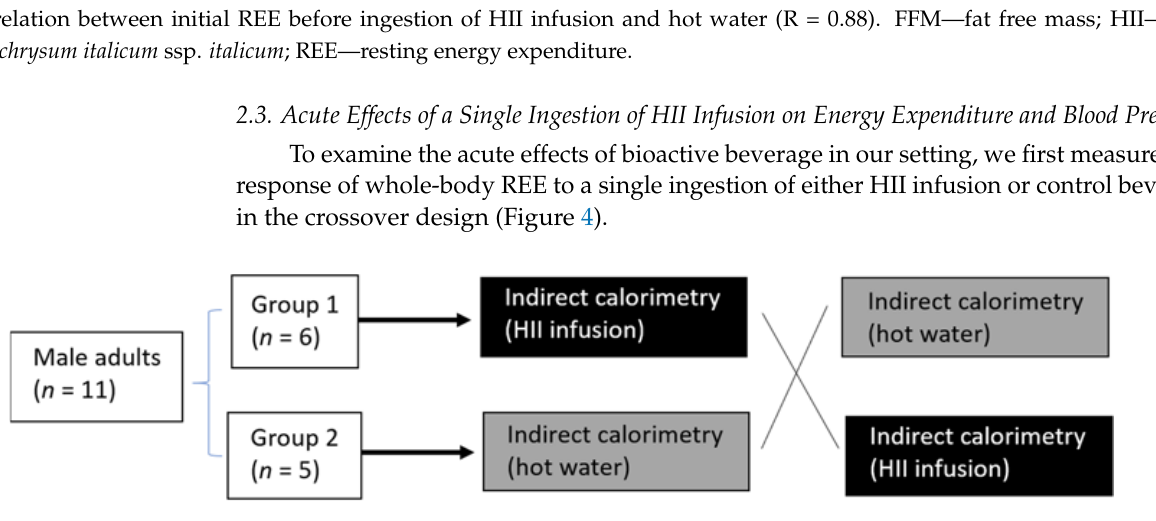
Figure 4. Study protocol for the acute pilot trial; randomized, controlled, crossover study.